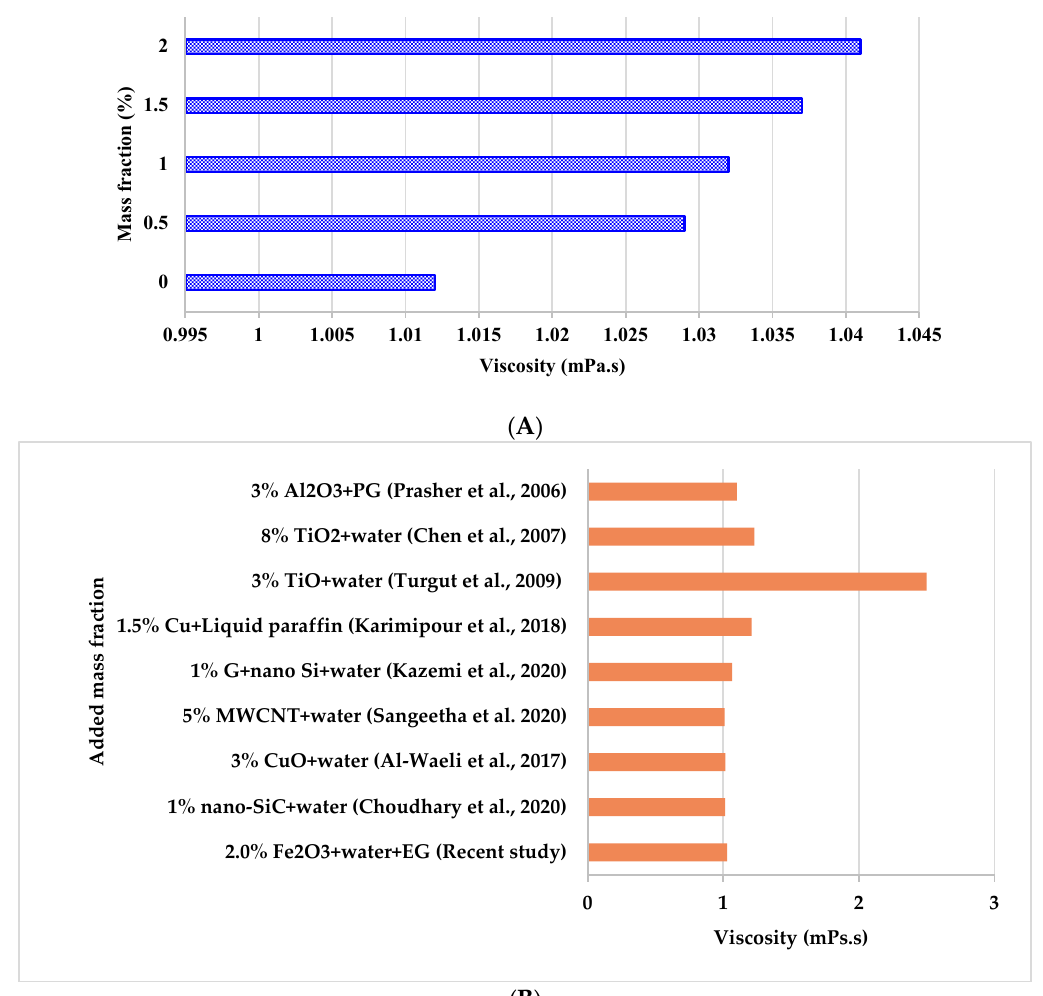
Figure 3. The effect of mass fraction added on resulted nanofluid viscosity ( A ), and a comparison between recent study viscosity and others from literature ( B ).